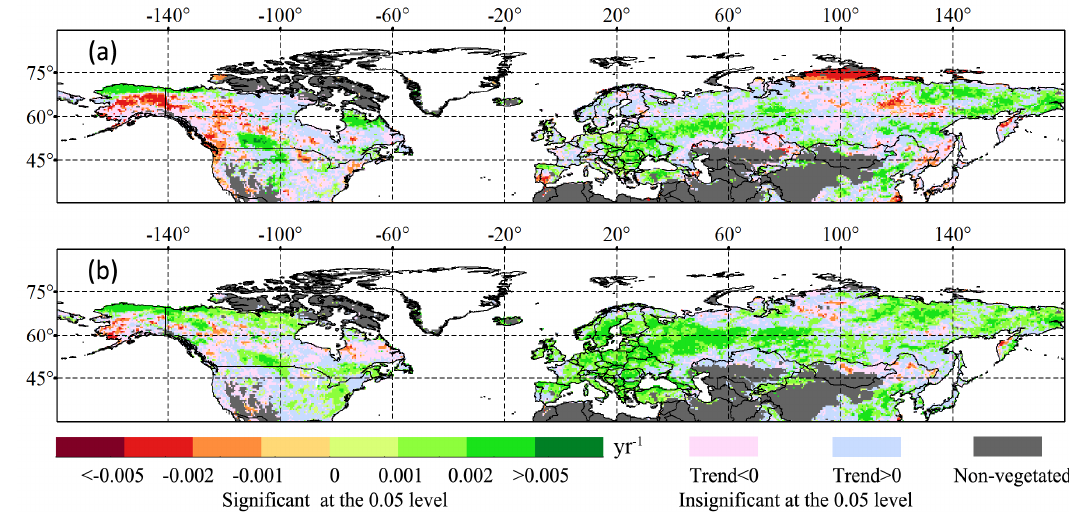
Figure 2. Overall changing trends in the growing-season NDVI detected from ( a ) NDVIg and ( b ) NDVI3g during 1982–2008.